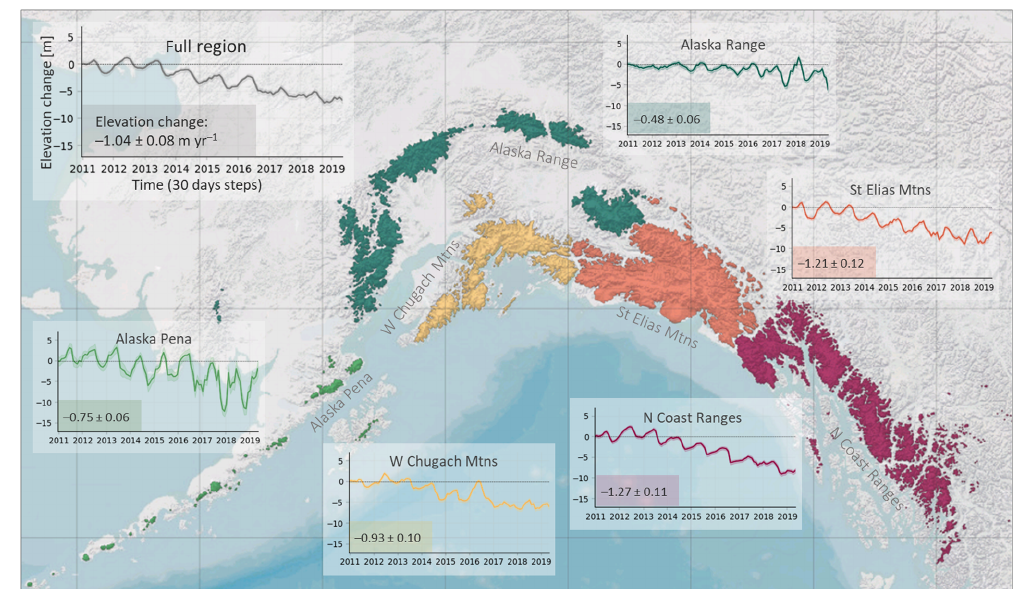
Figure 9. Gulf of Alaska (GoA) monthly elevation change time series on a sub-regional level. The coloured lines display the time series with the uncertainty envelope ( y axis: elevation change [m]; x axis: time [30d steps]). The numbers describe the elevation change with uncertainties in myr − 1 .